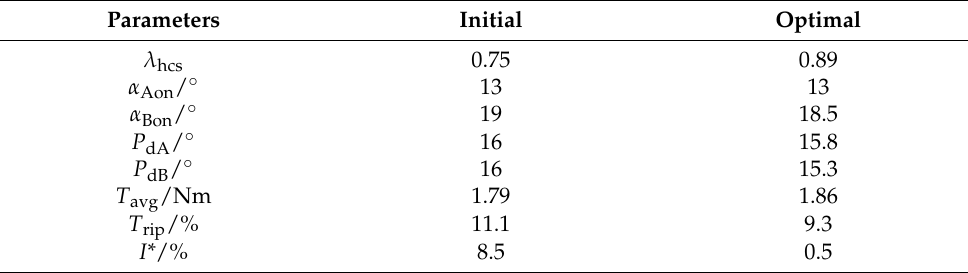
Table 5. Initial and optimal parameters of 12/10